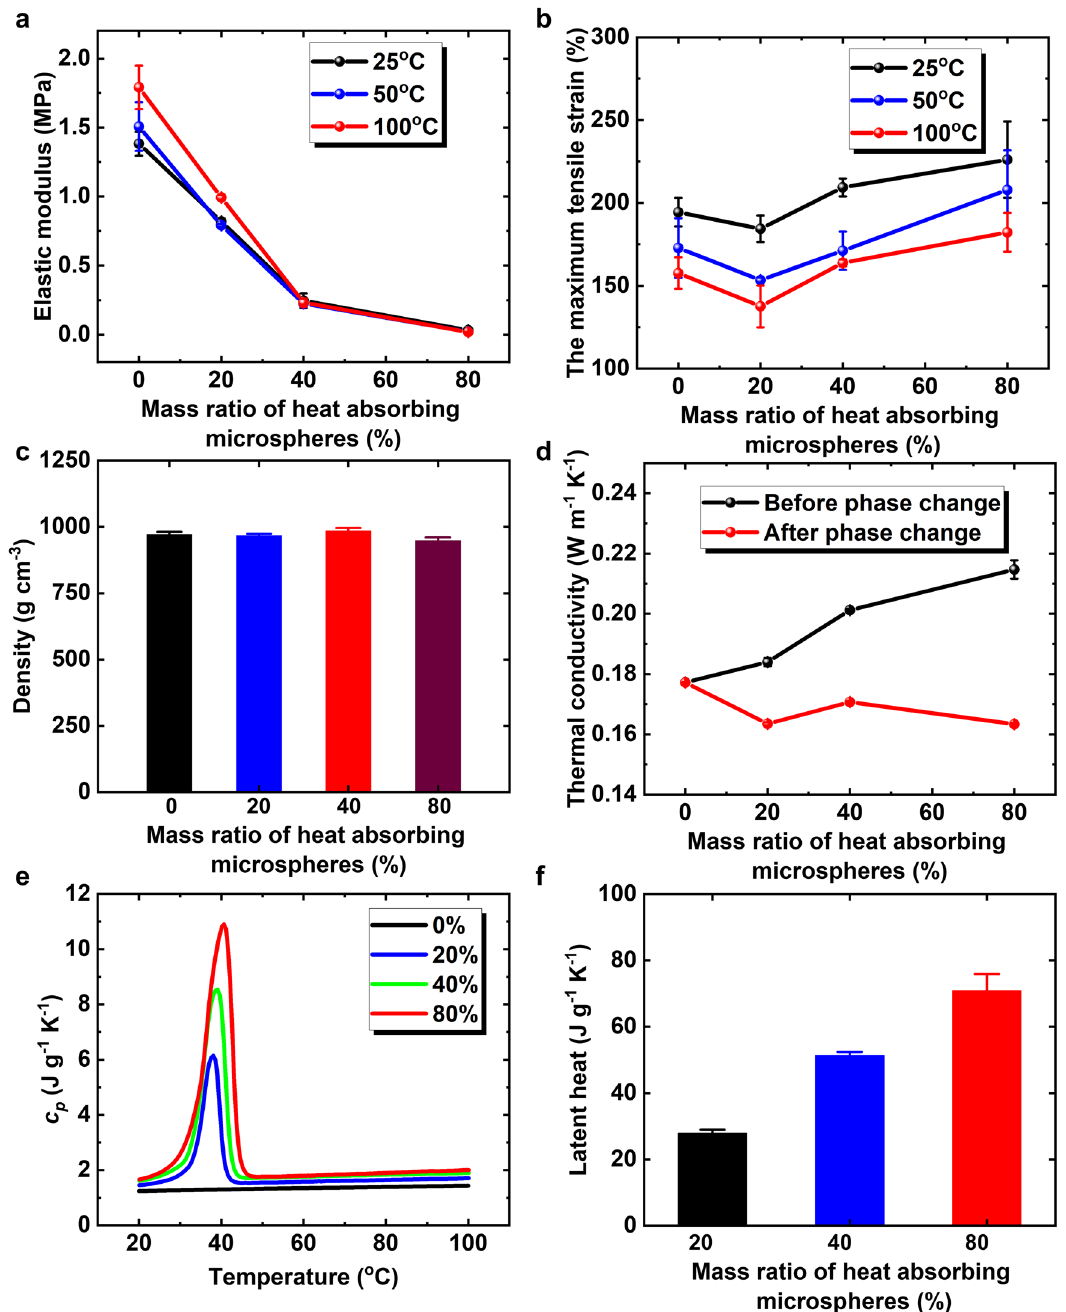
Fig. 2 Mechanical and thermal properties of TPS. a The elastic modulus of TPS and b the maximum tensile strain of TPS versus the mass ratio of heat-absorbing microspheres under different temperatures. c The density of TPS versus the mass ratio of heat-absorbing microspheres. d The thermal conductivity of TPS versus the mass ratio of heat-absorbing microspheres before the phase change (25 o C) and after the phase change (50 o C). e The variation of the speci fi c heat capacity of TPS with temperature under different mass ratios of heat- absorbing microspheres. f The latent heat of TPS versus the mass ratio of heat-absorbing